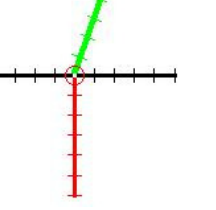
Figure 1: Intersection with red line the way the wayfinder came from, green line the way the wayfinder should go and black lines the wrong choices (Grum,